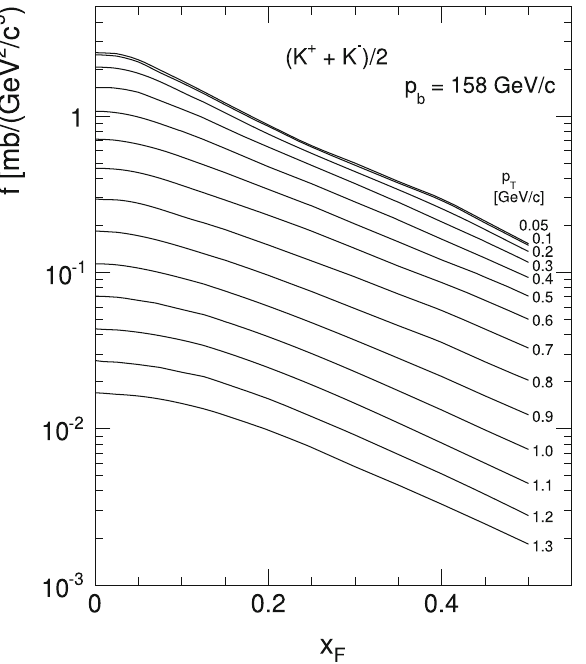
Fig. 11 f ( x F , p T ) for K 0 as a function of x F at p beam = 158 GeV/c S obtained from the average charged kaon yields [49]